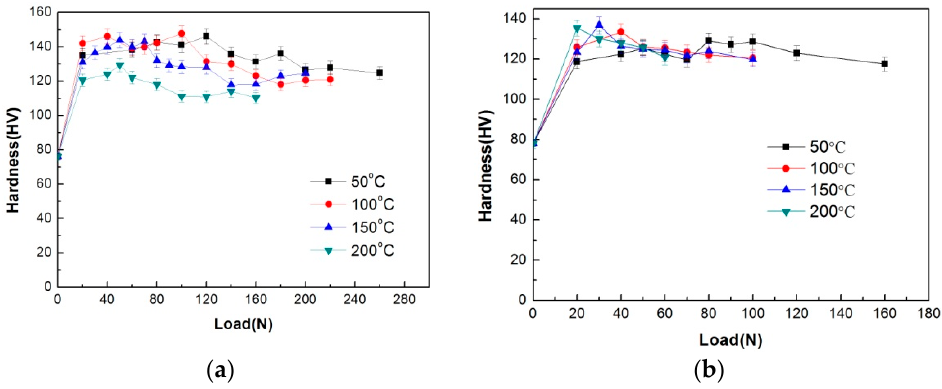
Figure 6. Hardness of worn surface under different sliding speeds: ( a ) 0.8 m/s, ( b ) 3.0 m/s.